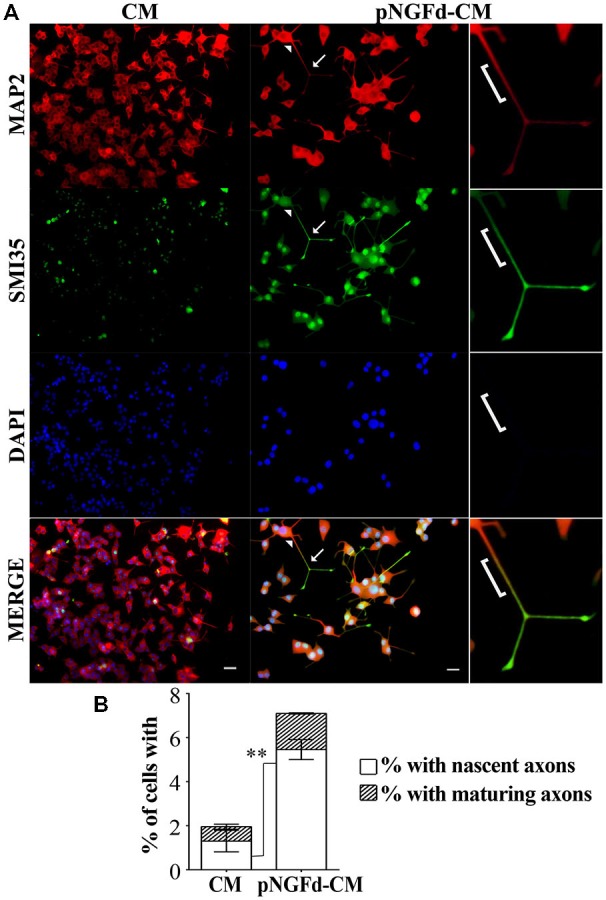
pNGFd-CM promotes axonal generation and maturation. (A) Immunofluorescence images of PC12 cells treated with CM and pNGFd-CM for 13–14 days. Cells were double labeled with antibodies for dendrites (MAP 2, red) and axons (SMI35, green). DAPI was used to visualize the nucleus. Arrowhead point to a neurite proximal part, bracket indicates the neurite middle part, expressing the dendritic and the axonal markers and arrows indicate the axons (distal part of the neurites). The insets show enlargement of the cell parts pointed by arrows. Scale bars = 20 μm. (B) Graph bars show the percentages of cells with axons (whole bars), nascent axons (white bars) and maturing axons (hatched bars). Graph values represent the mean ± SEM. **p < 0.01 (two-tailed t-test). Maturing axons were not different between CM and pNGFd-CM (p > 0.05). N = 3 independent experiments. Total number of cells: CM, n = 466; pNGFd-CM, n = 291.